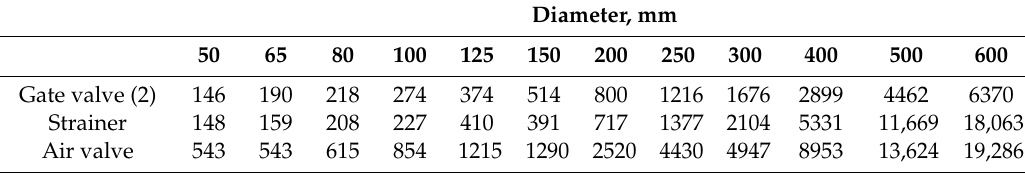
Table 1. Additional costs related to the PRV installation.